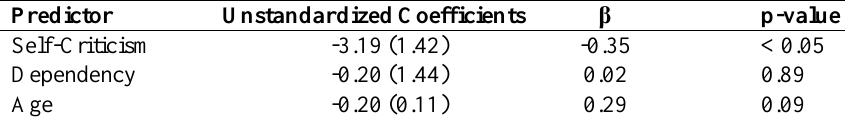
Table 4: Regression Analyses for Self-Criticism as Predictor of Change in Depressed Mood (POMS) Predictor Unstandardized Coefficients β p-value Variable (Std. Error) Self-Criticism -3.19 (1.42) -0.35 < 0.05 Dependency -0.20 (1.44) 0.02 0.89 Age -0.20 (0.11) 0.29 0.09 Notes: Outcome variable - POMS Depression ∆ Time 2, Std. – Standard; β = standardized coefficient; Model: p < 0.05, r = 0. 46, r2 = 0.21, n =